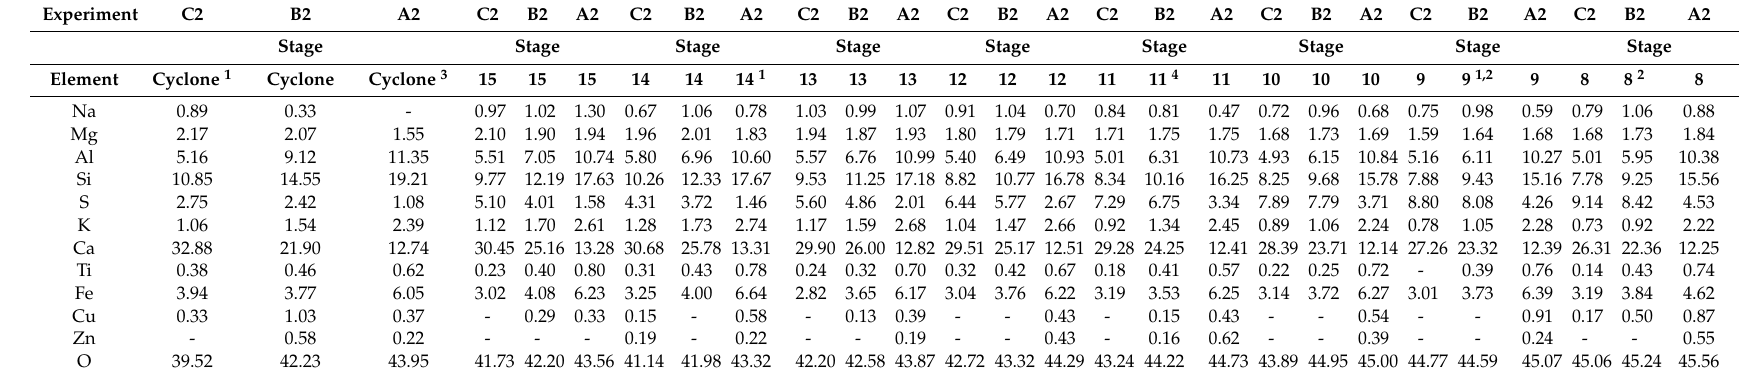
Table 6. Elemental concentration (wt% of fly ash particles) per stage and experiment for staged combustion conditions.